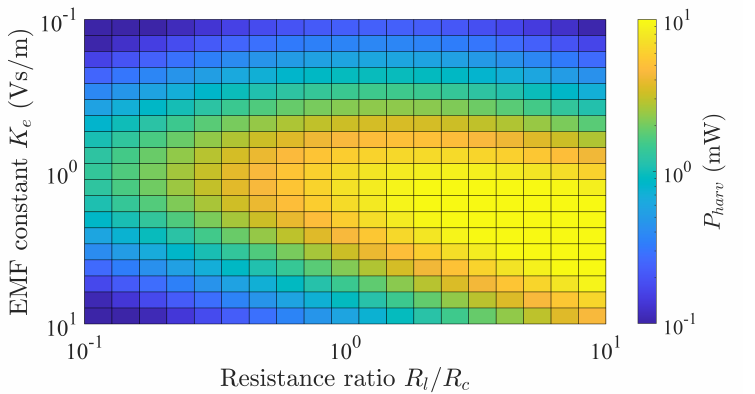
Figure 8. Simulated results of harvested power as a function of load resistance and EMF constant.